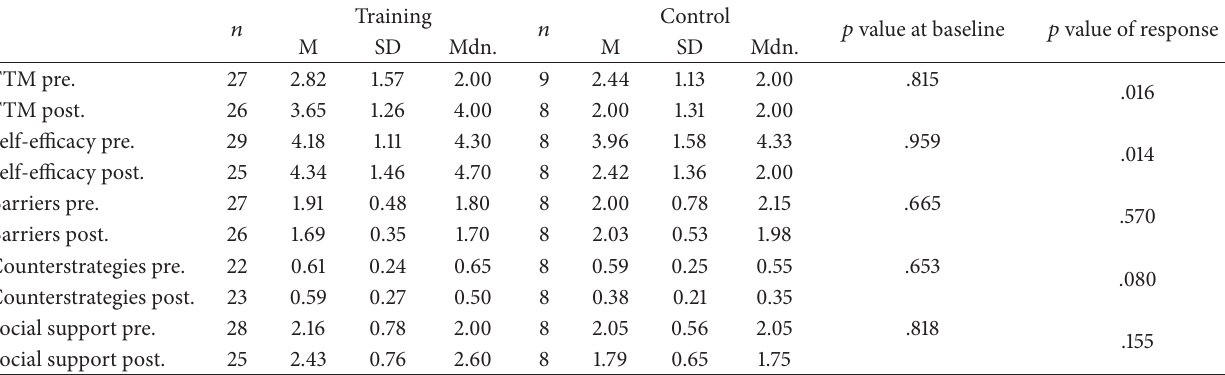
Table 2: Means (M), standard deviations (SD), and median (Mdn.) of motivational variables of the groups for pre- and posttreatment assessments. 𝑛 Training 𝑛 Control 𝑝 value at baseline 𝑝 value of response M Mdn. M SD Mdn. TTM pre.